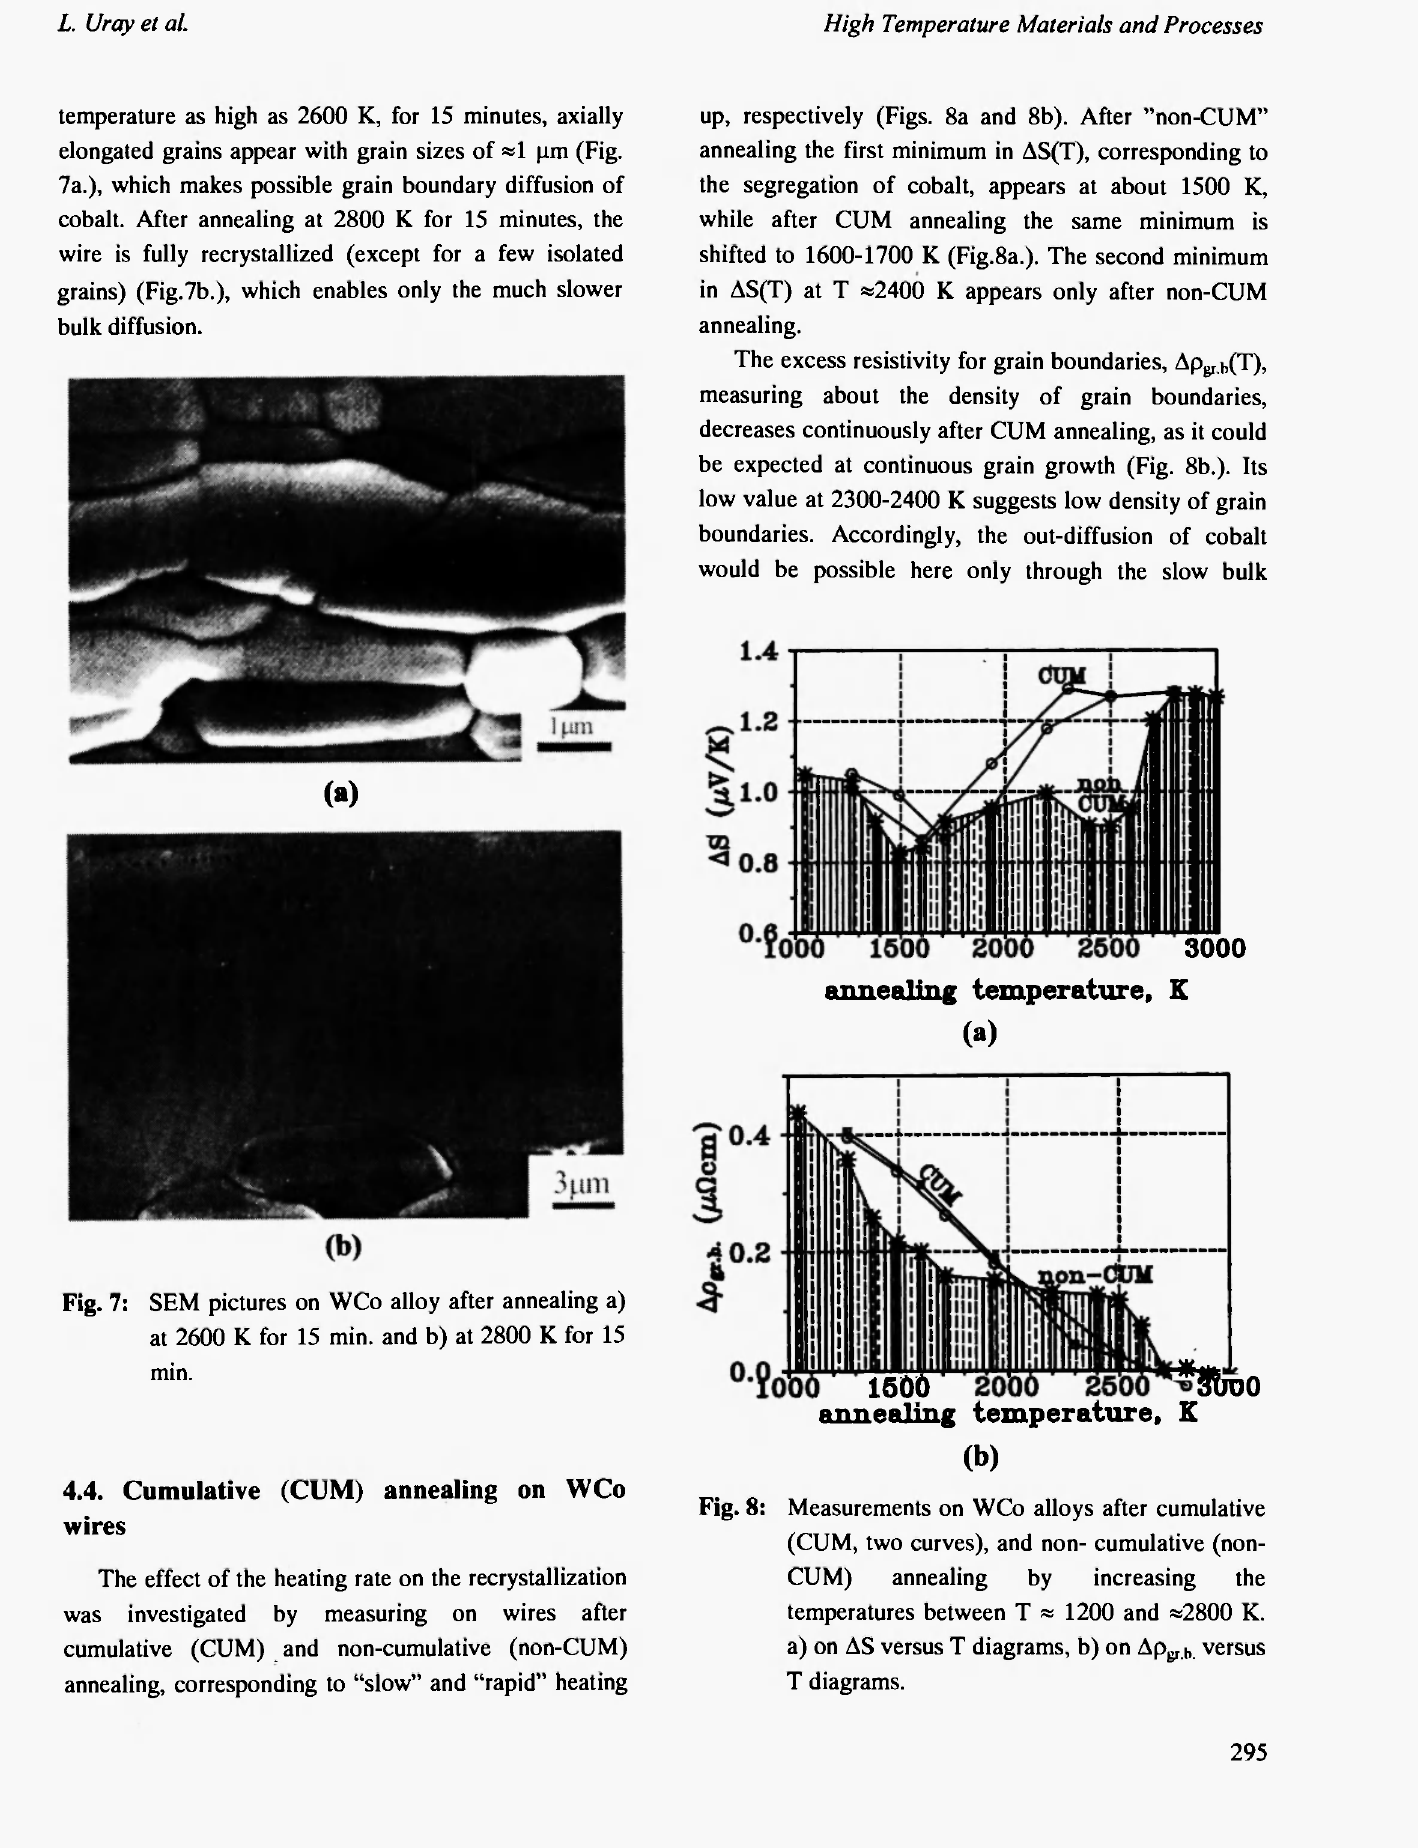
Fig. 8: Measurements on WCo alloys after cumulative (CUM, two curves), and non- cumulative (non- CUM) annealing by increasing the temperatures between Τ » 1200 and «2800 K. a) on AS versus Τ diagrams, b) on Apg, h versus Τ